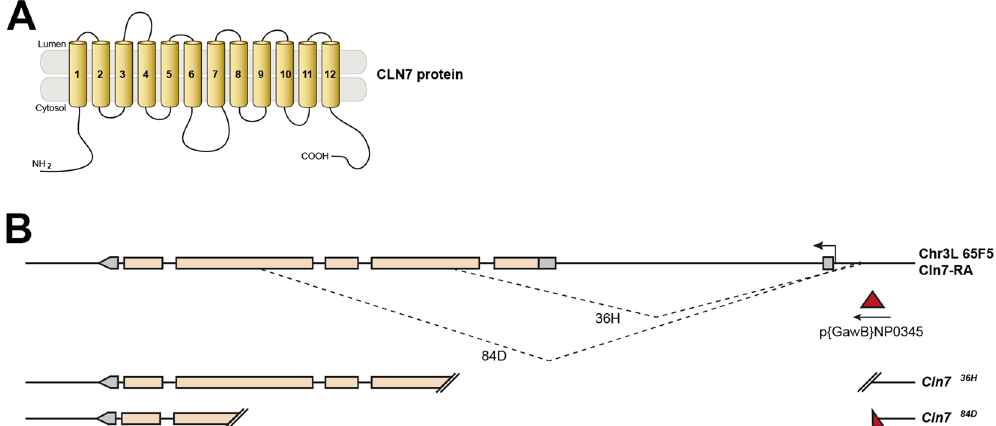
Figure 1. Generation of Cln7 mutations. ( A ) Cln7 is predicted to be a 12-span transmembrane protein and member of the multifacilitator superfamily of solute transporters. ( B ) P-element-mediated imprecise excision was used to generate deletions within the Cln7 locus (CG8596). Two unidirectional deletion events, 36H and 84D, are shown diagrammatically. Some of the P-element sequence is retained in the 84D